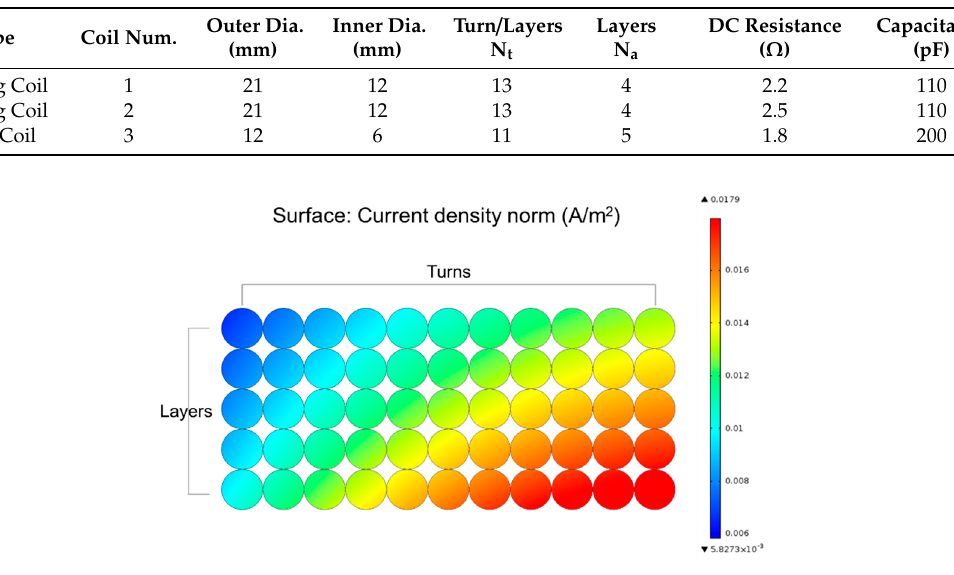
Figure 6. Cross section of surface current density of implant coil in COMSOL simulation when the transfer distance is 5 mm.